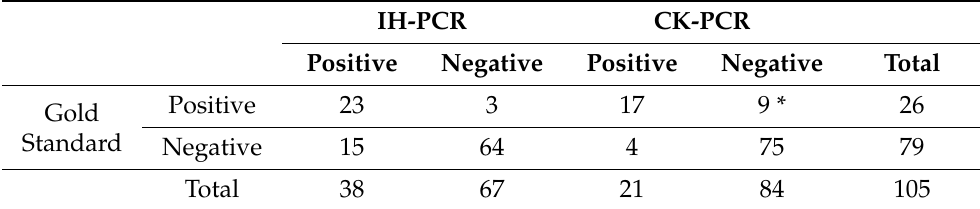
Table 2. Contingency table of the in-house (IH)- and commercial kit (CK)-PCR results compared to the diagnostic gold standard for the detection of dermatophytoses.